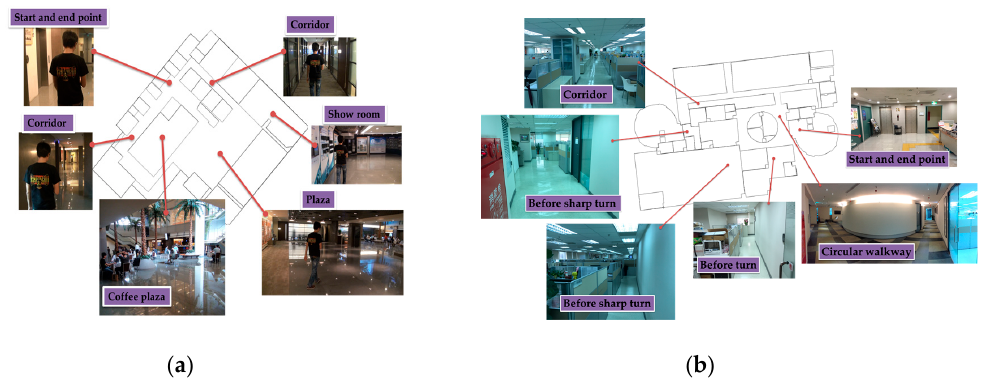
Figure 11. This figure shows the experimental environments of III and enterprise: ( a ) The environment of enterprise; ( b ) The environment of